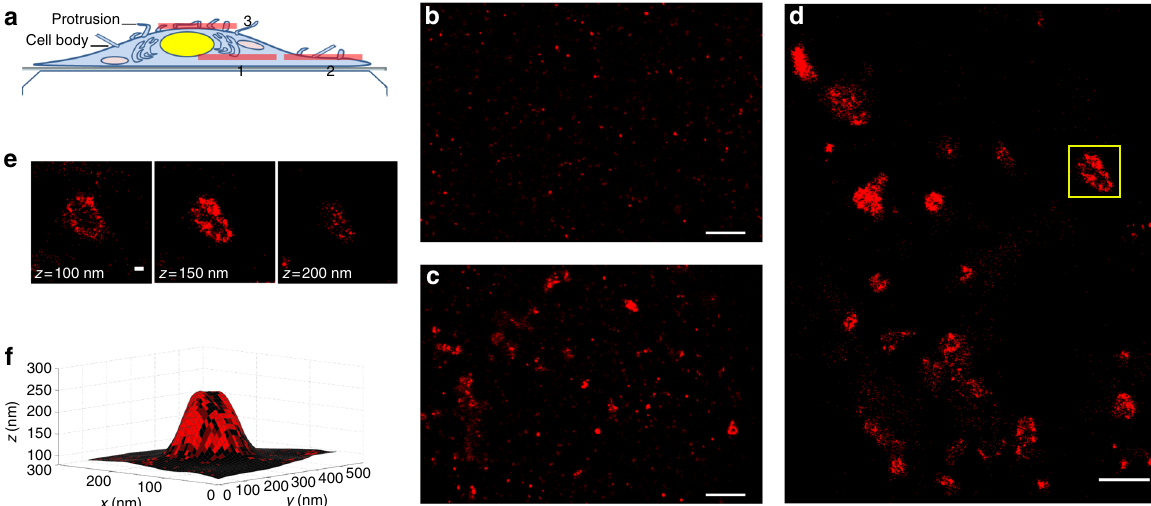
Fig. 1 Distribution of NiV-M in PK13 cells. PK13 cells expressing NiV-M were fi xed, permeabilized, and labeled with goat anti-GFP and anti-goat Alexa Fluor 647 antibodies. a Schematic illustration of the imaging planes of a cell. b x – y cross section (100 nm thick in z ) of a region through the middle (position 1 in a ) of a representative cell showing the M clusters. Scale bar: 1 μ m. c x – y cross section (100 nm thick in z ) of a region at the plasma membrane (position 2 in a ) of a representative cell showing larger M clusters. Scale bar: 1 μ m. d x – y cross section of a region (position 3 in a ) of a cell showing a